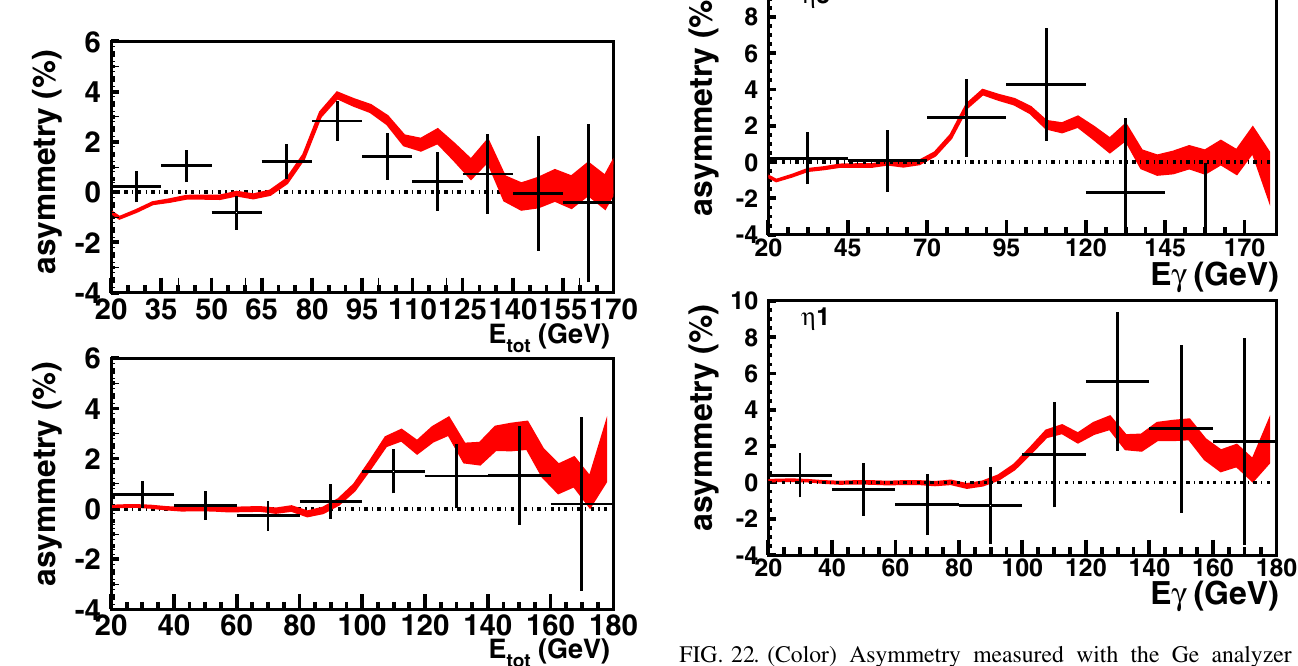
FIG. 22. (Color) Asymmetry measured with the Ge analyzer (top) and the pair spectrometer (bottom). The data sample with FIG. 21. (Color) Asymmetry measured with the calorimeter. a fully reconstructed single e (cid:9) e (cid:1) pair is 10 times smaller than (top) and generation of the total data sample with at least one pair passing all the data The results reflects the changes in (cid:2) 3 (cid:2) (bottom) due to the presence of the quarter wave quality cuts and with a 2MIPs cut (see Sec. IVA) in S11. 1